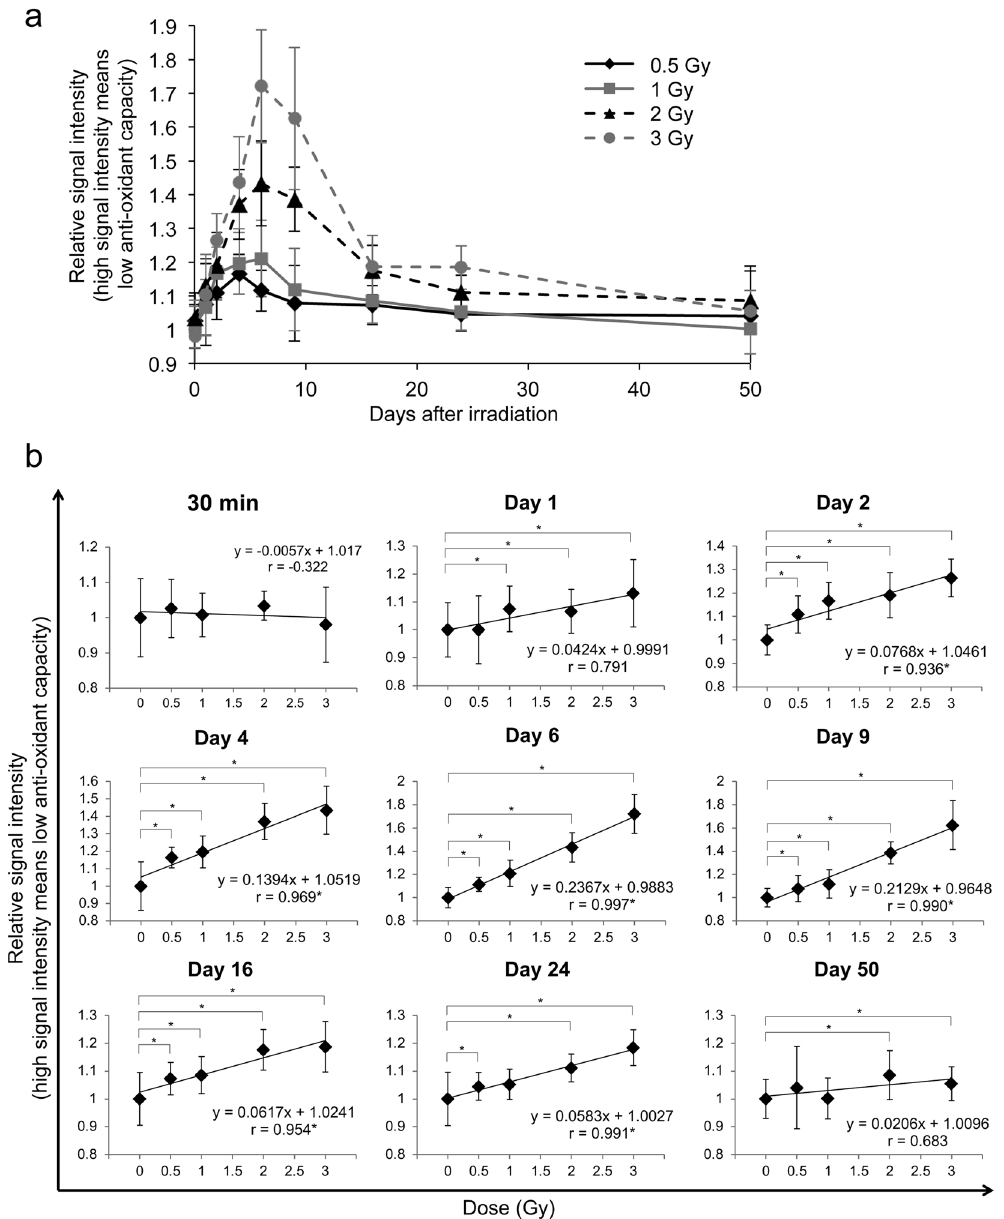
Figure 1. Changes in whole-blood anti-oxidant capacity after irradiation. Whole-blood anti-oxidant capacity was measured using i-STrap. High signal intensity means low anti-oxidant capacity. ( a ) Changes in anti-oxidant capacity after irradiation. ( b ) Evaluation of dose dependence at various time points. All quantitative data are presented as the means ± SD (n = 12–14). * P < 0.05, Welch’s t -test and Pearson’s correlation coefficient